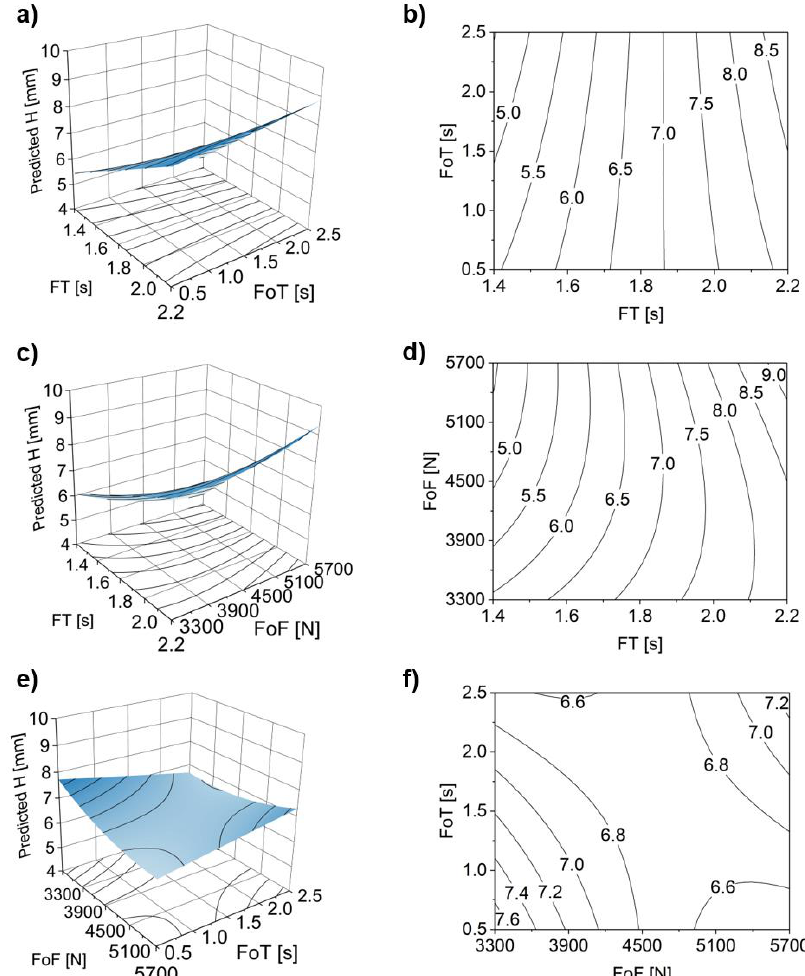
Figure 12. Two-way parameter interactions with rivet penetration depth (H) as response. Surface and contour plots for: ( a , b ) friction time (FT) and forging time (FoT); ( c , d ) FT and forging force (FoF); and ( e , f ) FoT and FoF.